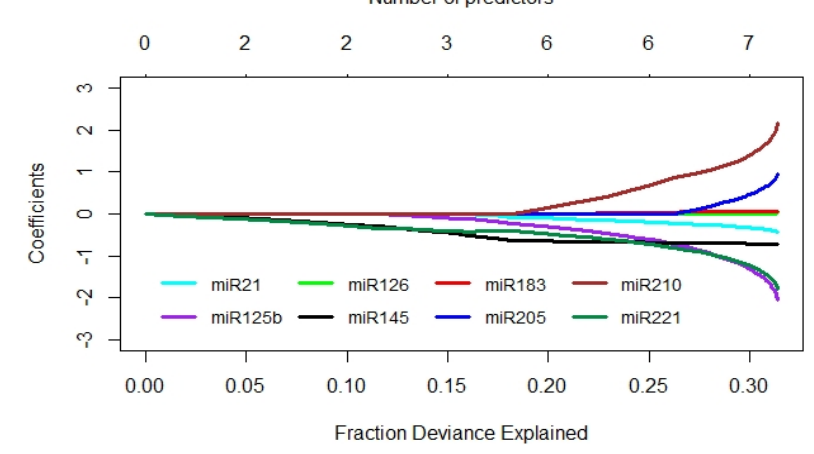
Figure 4. Diagnostic value of the miRNAs assessed by penalized linear regression. The deviance profile plot corresponding to standardized miRNAs as predictor variables in the glmnet model is shown. The slope of each path changes each time as another miRNA enters the model. The miRNAs, which explain a larger fraction of deviance, play a more important role in the prediction of the tumor status.